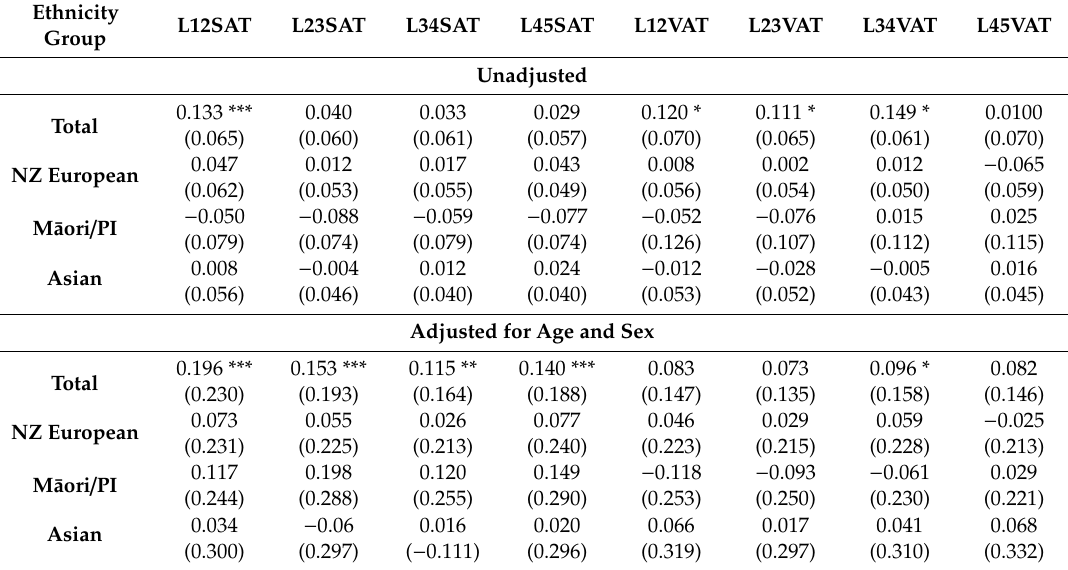
Table 4. Regression result for ethnicity-specific associations between WC and fat depositions.